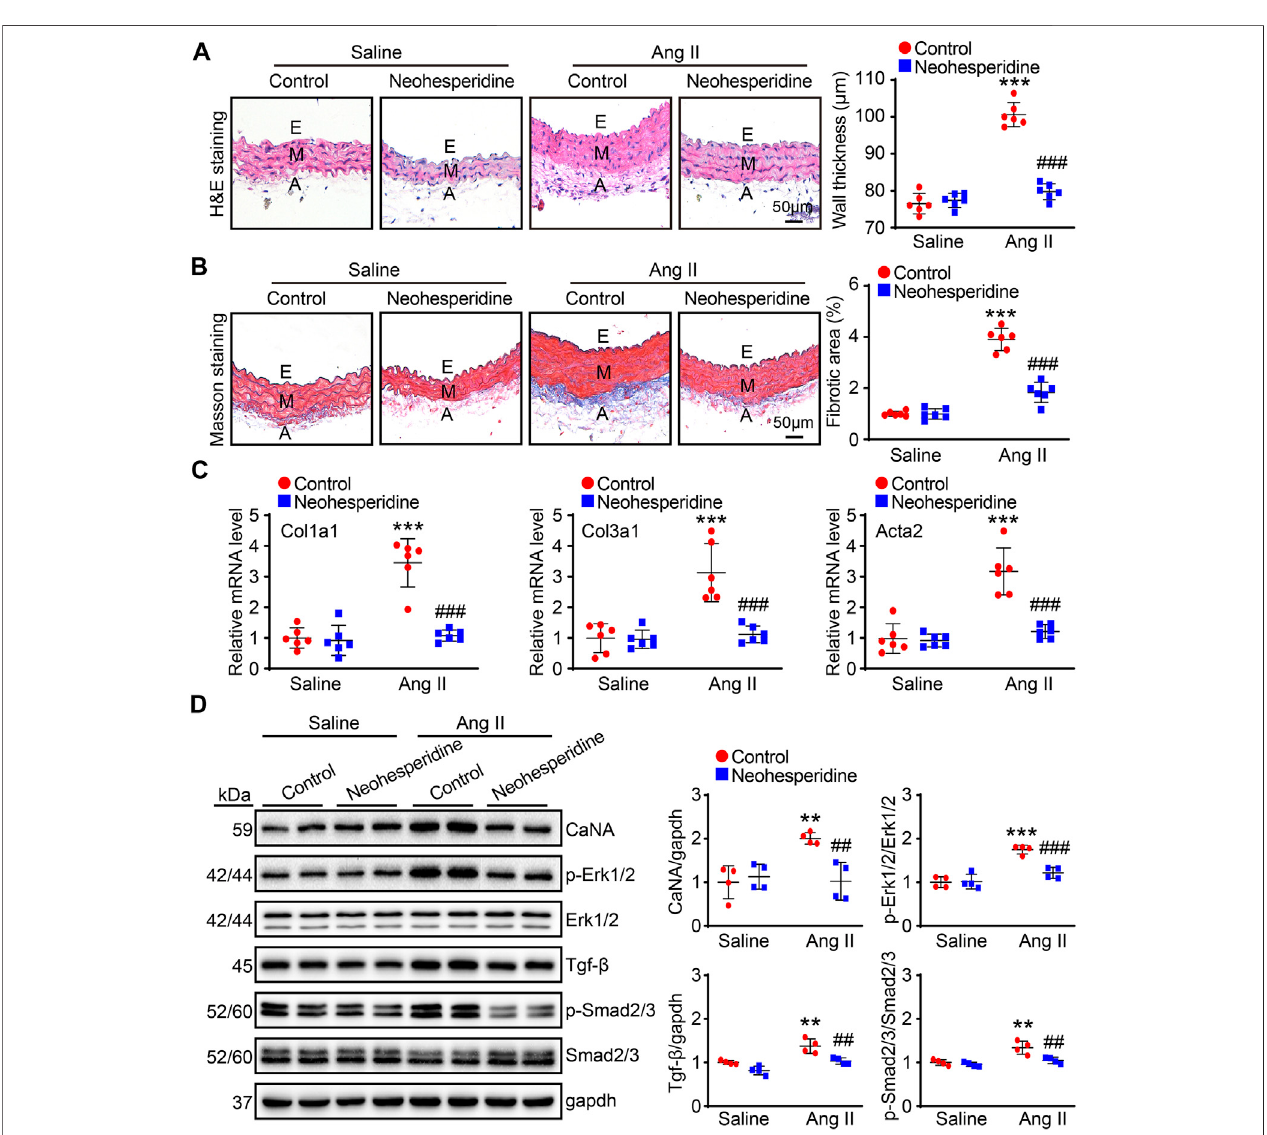
FIGURE 3 | Neohesperidin alleviates Ang II-induced vascular hypertrophy and sclerosis. Mice were infused with Ang II (490 ng/kg/min) by Alzetmodel 1,002 micropumpfor2 weeks.AcaudalveininjectionofNeohesperidin(50 mg/kg/day)wasperformedfor16 days (A) RepresentativeimagesofH&Estainingfromeachgroup (left panel, Bar=50 μ m).Histogram ofmeasuredaorticwallthickness (rightpanel, n =6) (B) Representativeimages ofMasson ’ strichrome stainingfromeach group(left panel, Bar =50 μ m).Histogramofmeasured fi brotic area (rightpanel, n = 6) (C) qPCR analysisofCol1a1, Col3a1, and Acta2 mRNA levels from each group ( n =6) (D) the protein level ofCaNA, p-Erk1/2,Erk1/2, Tgf- β , Smad2/3, and p-Smad2/3 ( n =4). Statistical analysiswas performed withone-way ANOVA. ** p < 0.01 and *** p < 0.001, sham vs. Ang II; ## p < 0.005 and ### p < 0.001, Ang II vs. Ang II +